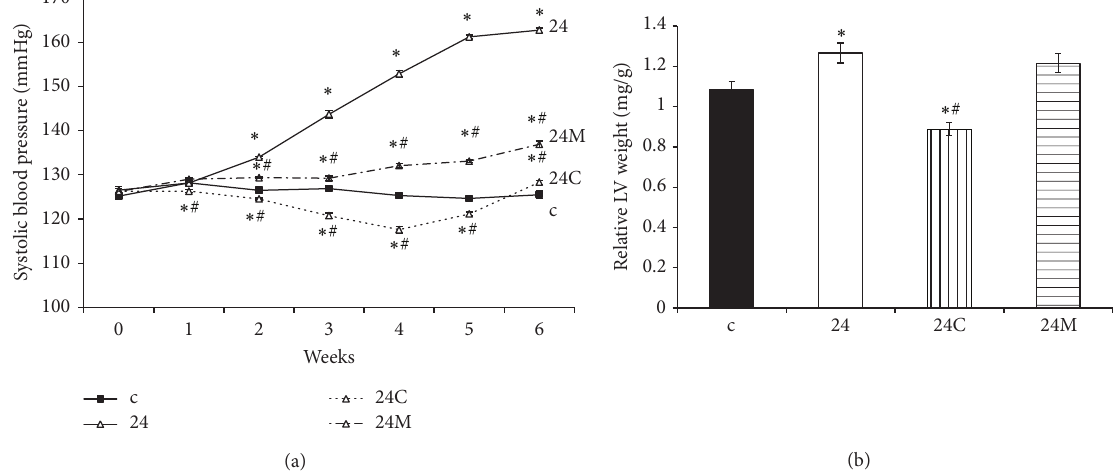
Figure 1: The influence of captopril (24C) and melatonin (24M) on blood pressure (a) and relative left ventricle (LV) weight (LVW/BW) (b) in 24 hours/day continuous light exposure-induced hypertension (24). c: Wistar controls. ∗ 𝑃 < 0.05 versus c; # 𝑃 < 0.05 versus 24.